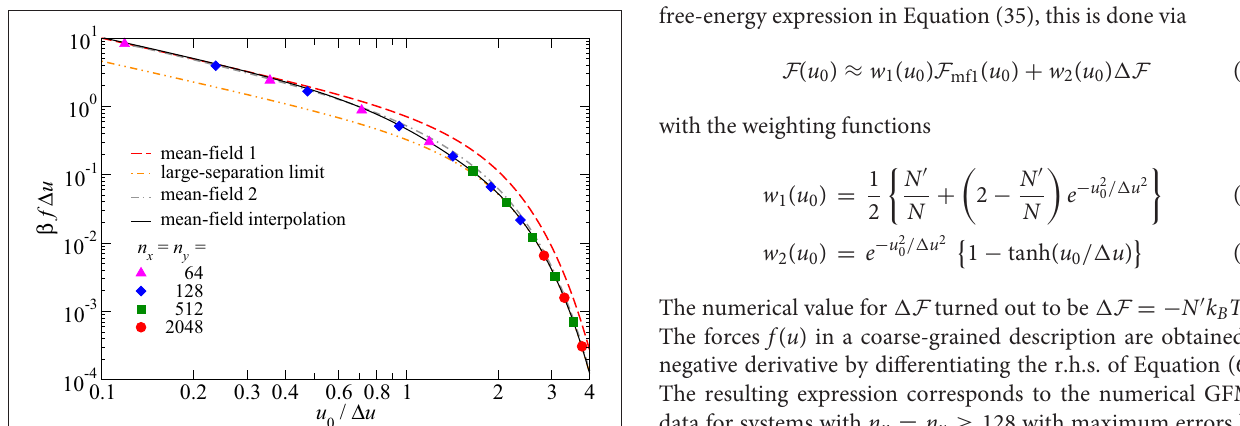
Equation (59) can be solved for d T with the help of the Lambert W function W ( x )